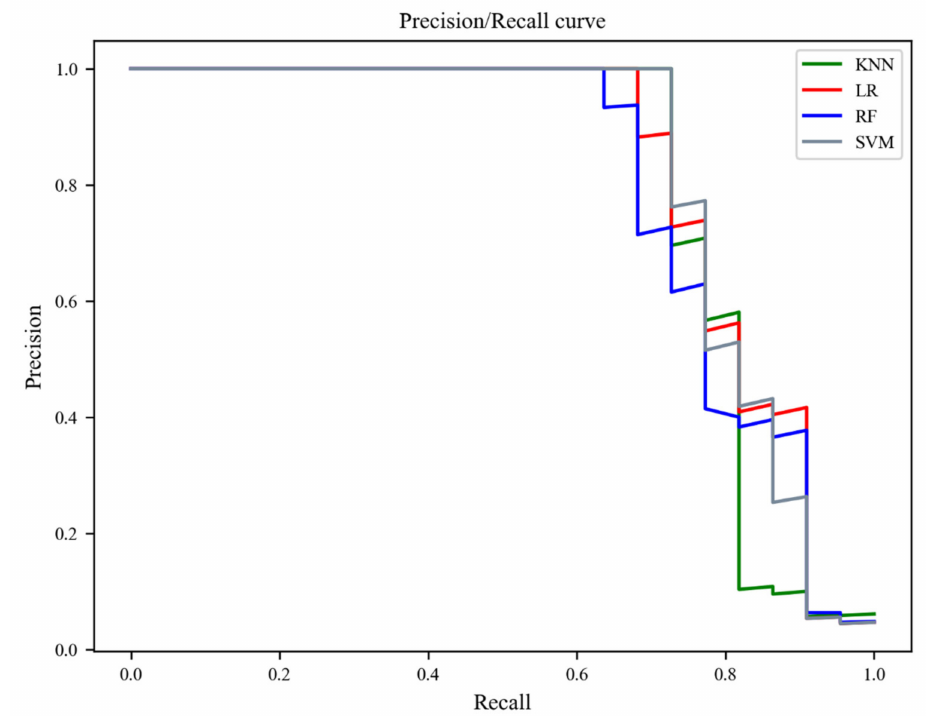
Figure 7. Precision–recall curves of KNN, LR, RF, and SVM on robust data after being filtered by multi-source semantic